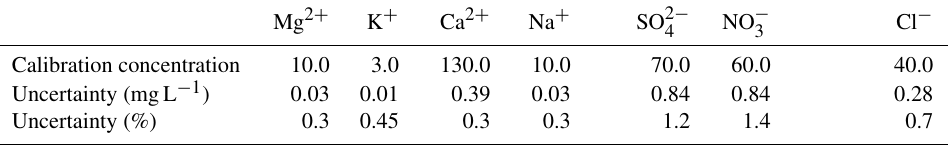
Table 1. Assessment of the RL accuracy and instrumental drift based on concentration measurements made after several injections of the standard solution “River × 1”. The uncertainty on the calibration solution is the quadratic sum of the uncertainty on the standard solutions (provided by the manufacturer) and the overall uncertainty for weighing during solution preparation. Measurement errors over 1 week and over 2 months are expressed as the relative standard deviation (RSD) calculated for repeated injections of the solution “River × 1” directly into the IC instruments via the multiport valve (see Fig.